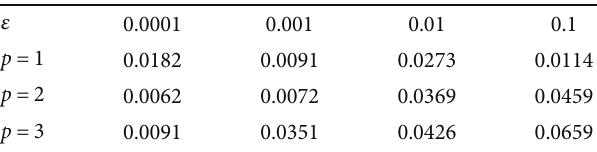
Figure 20: The variations of the system of equations (46) and the solution of the regularized system of equations (12) – (15) for p = 3 , k = 1 : 4 , α = 0 : 0001 , and y = 1 . Table 1: The relative root mean square errors at y = 1 for various noisy levels with k = 0 : 5 .